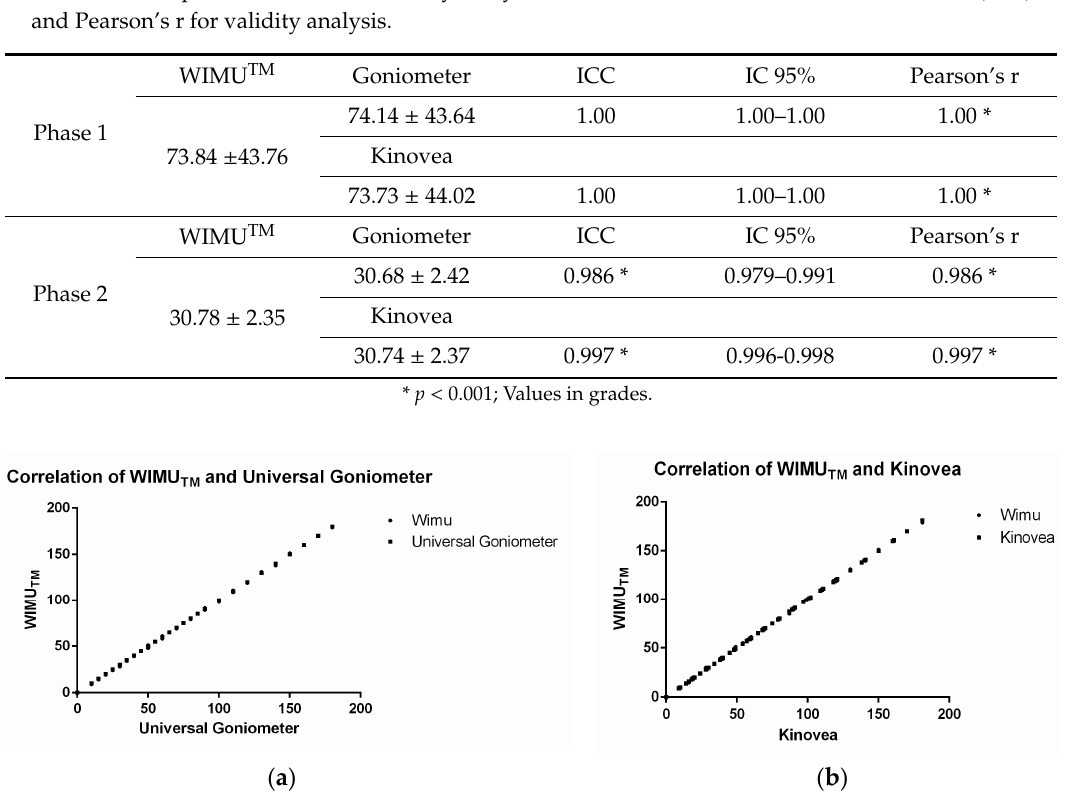
Table 1. Descriptive statistics and validity analysis based on intraclass correlation coefficients (ICC) and Pearson’s r for validity analysis.